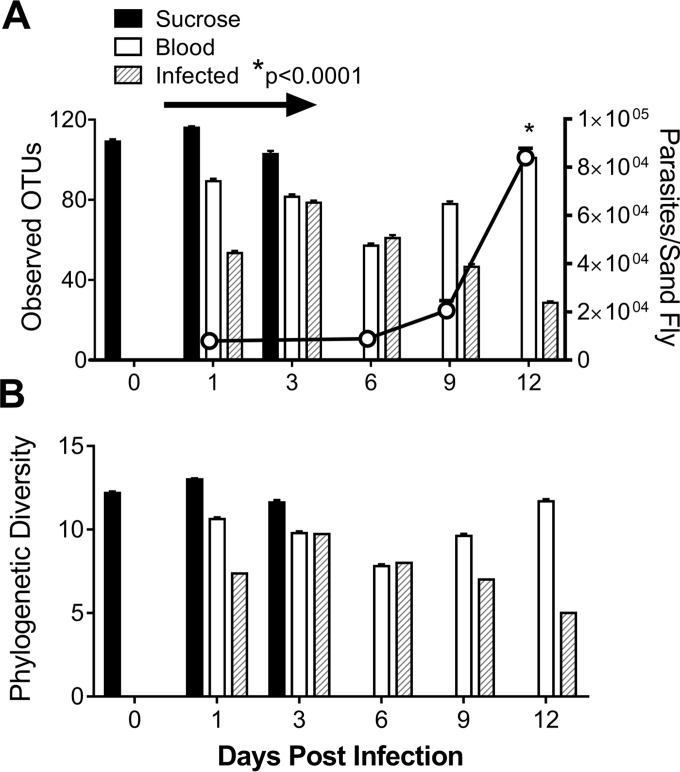
L. infantum parasite burden is inversely correlated with bacterial richness in infected sand fly midguts, measured in numbers of OTUs at the species (A) or phylum (B) level. (A) The total number of OTUs obtained by bacterial 16S rDNA sequencing of DNA derived from the gut of sand flies fed on different meals (bars, left y axis) was determined in triplicate pools of 20 sand fly midguts under each condition, in three separate biological replicate experiments. The parasite burden represents the mean of results of 3 separate experiments in which parasites in 10 infected flies from each condition were counted microscopically. Panel A (line graph, right y axis) shows the means ± standard errors (SE) of the results from 3 replicate experiments. *, 2-way ANOVA with Tukey posttest was performed between treatments over time. The arrow indicates the duration of detectable blood in sand flies fed on blood. (B) UniFrac diversity metric over time in each treatment group. Sucrose-fed flies were obtained for the day 0 to day 3 time points. Data for days 0 to 9 are from three independent experiments; data for day 12 are from two independent experiments. Each experiment included triplicate pools of 20 dissected sand fly midguts.